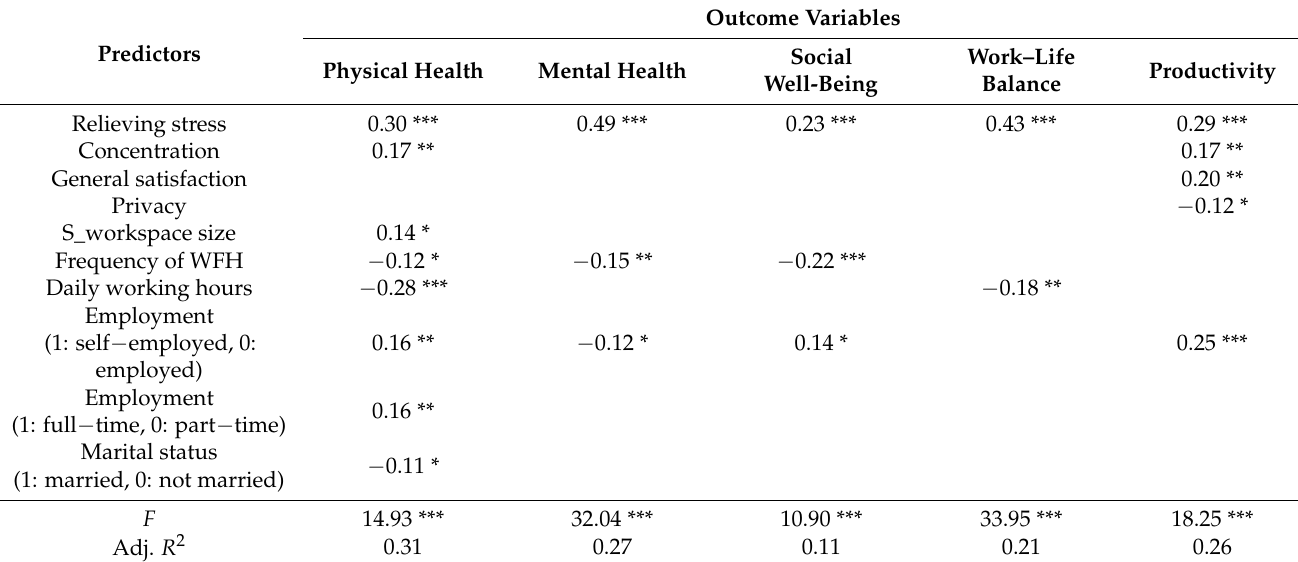
Table A2. Regression models (Beta coefficients) predicting changes in health and